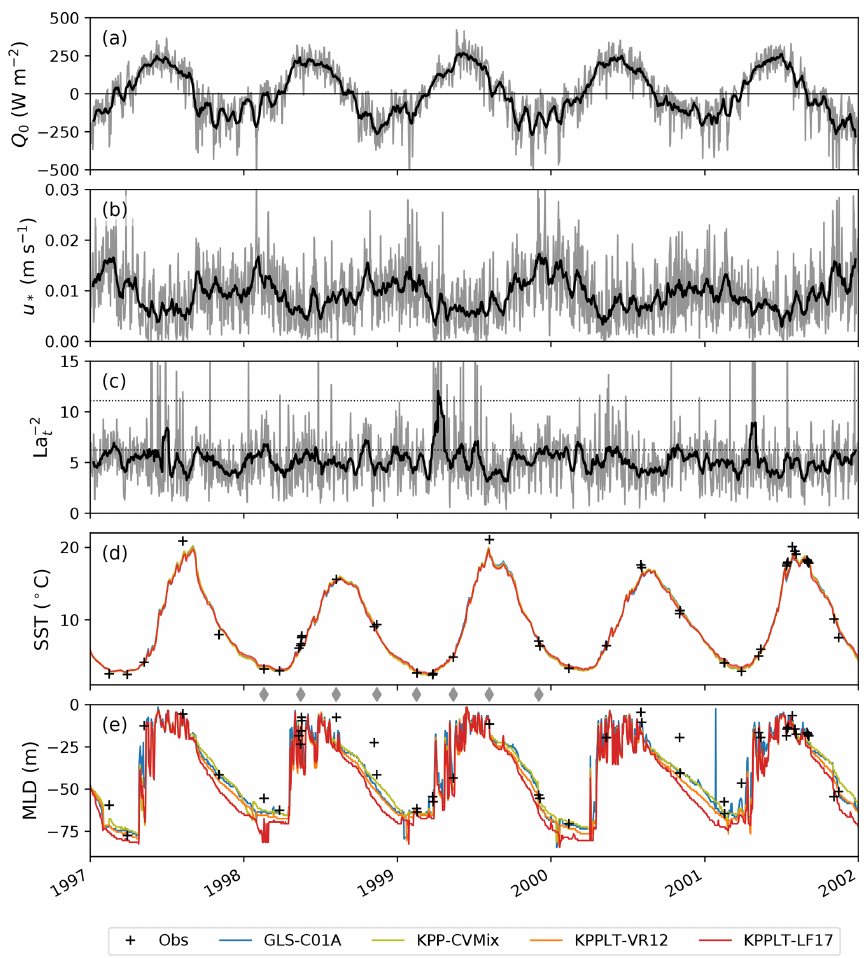
Figure 11. Five-year time series of (a) net surface heat flux (Wm − 2 ), (b) surface friction velocity (ms − 1 ), (c) La − 2 t where La t is the turbulent Langmuir number, (d) sea surface temperature (SST; ◦ C), and (e) MLD (m), defined by a 0.2 ◦ C temperature threshold referenced to the surface, at the Gotland Basin. In panels (a) – (c) , the thin line in gray shows the daily time series and the thick line in black shows the 15d moving average. The black dotted lines in (c) marks the values corresponding to La t = 0 . 3 and La t = 0 . 4. In panels (d) and (e) , the black plus signs show the observations at Gotland. Daily results of GLS-C01A, KPP-CVMix, KPPLT-VR12, and KPPLT-LF17 are shown in blue, yellow, orange, and red, respectively. Gray diamonds between panels (d) and (e) mark the time when the vertical profiles of temperature are compared with the observations in Fig.